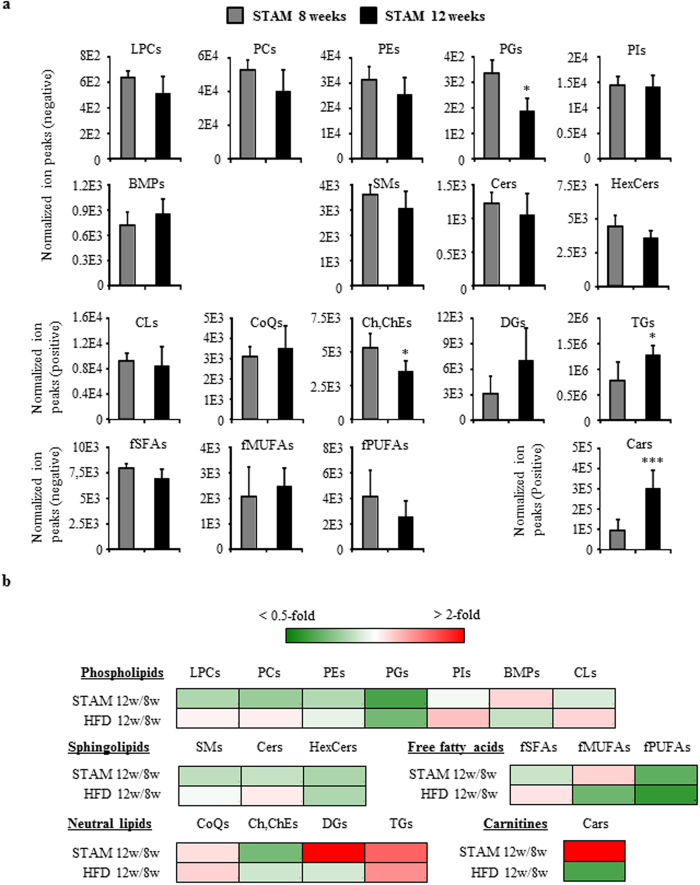
Global changes in hepatic lipid classes between STAM mice at 8 weeks and 12 weeks.a Lipid extracts were prepared from mouse livers as described in Materials and Methods, and abundance of individual lipid molecules were measured. Data are sum of ion peak heights of all molecules within each class, and shown as mean ± SD (n = 5 in each group). *p < 0.05; ***p < 0.005 when comparing between STAM mice at 8 weeks and 12 weeks. LPCs, lysophosphatidylcholines; PCs, phosphatidylcholines; PEs, phosphatidylethanolamines; PGs, phosphatidylglycerols; PIs, phosphatidylinositols; BMPs, bis(monoacylglycerol)phosphates; SMs, sphingomyelins; Cers, ceramides; HexCers, hexosylceramides; CLs, cardiolipins; CoQs, coenzyme Qs; Ch/ChEs, cholesterol and cholesterolesters; DGs, diacylglycerols; TGs, triacylglycerols; fSFAs, free saturated fatty acids; fMUFAs, free monounsaturated fatty acids; fPUFAs, free polyunsaturated fatty acids; Cars, acylcarnitines. b Heatmap showing fold change in each lipid class between age-matched control HFD and STAM mice. 8 w, mice at 8 weeks; 12 w, mice at 12 weeks.